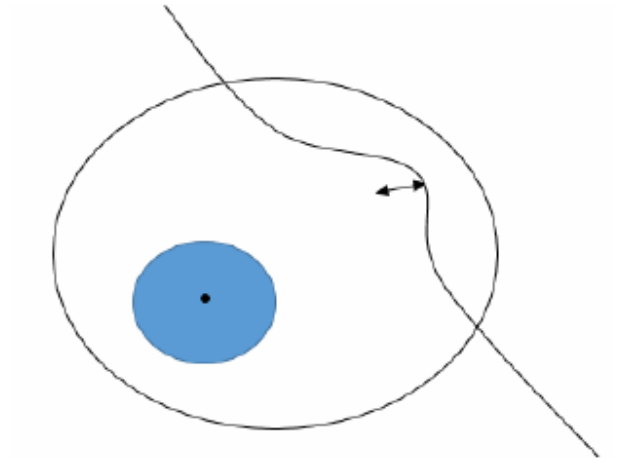
Figure 11. Type-6 binding constraint and its influence on classical linear constraints. Agents, especially in health-oriented systems, can not effectively behave using a set of algorithms. In certain conditions, every solution may be modified or changed. One of the frequent forms of change is defeasible reasoning. In practice, the software agent should defeat its goals aiming at better performance. Every rule should be gradually improved and modified and/or suddenly changed depending on the situation in a data-driven way. The defeasible scheme controls the usage of many unified exclusions and other defeasible knowledge